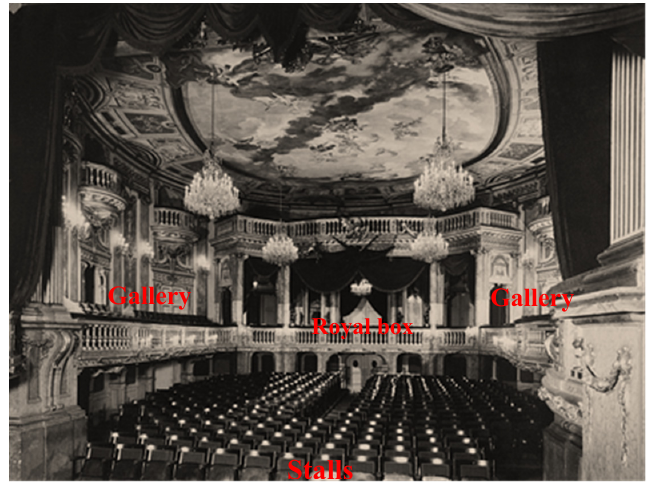
Figure 3. Recent picture of the Schönbrunn Theatre–Modified (copyright: Schlo ϐ Schönbrunn Kultur- und